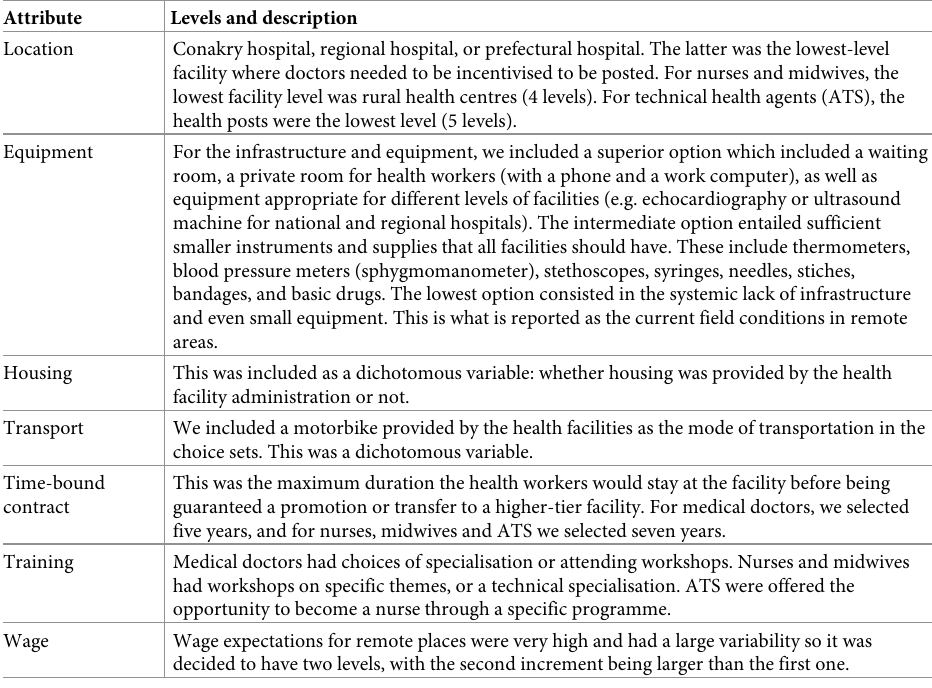
Table 1. Selected Discrete Choice Experiment